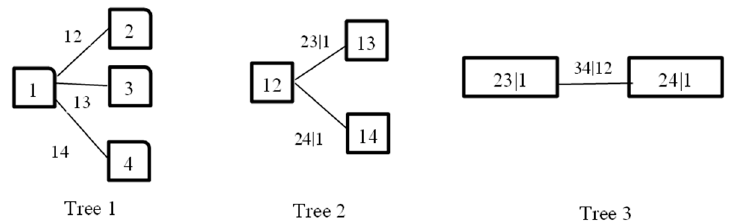
Figure 3. Frame of link-transmitting topology control.